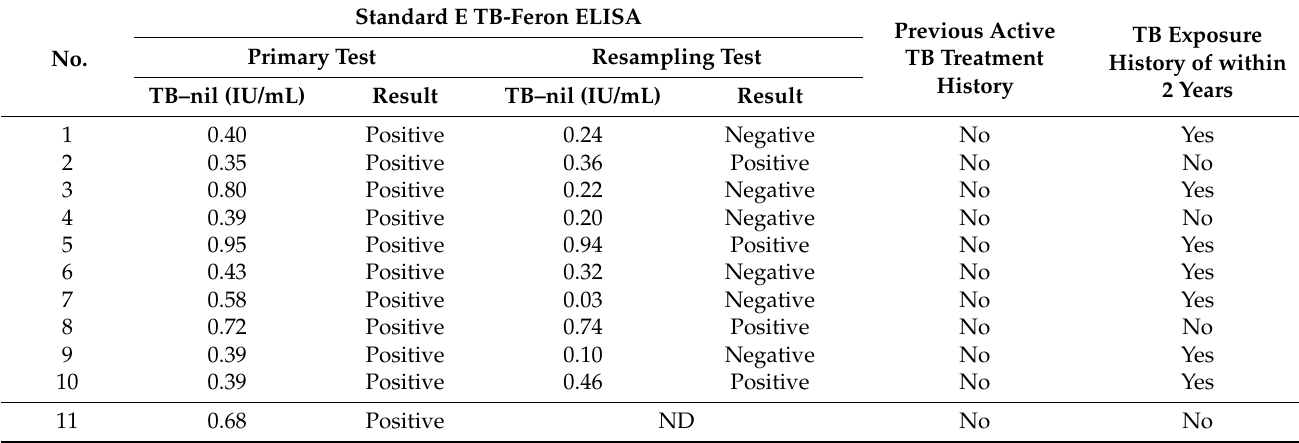
Table 3. IFN- γ values and active TB exposure history for 11 HCWs with discordant results between Standard E TB-Feron ELISA (positive) and QuantiFERON-TB Gold Plus assays